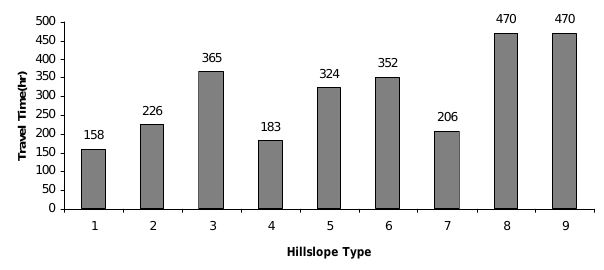
Fig. 10. Subsurface travel time (STT) of the nine basic hillslopes (N=50mm/day)